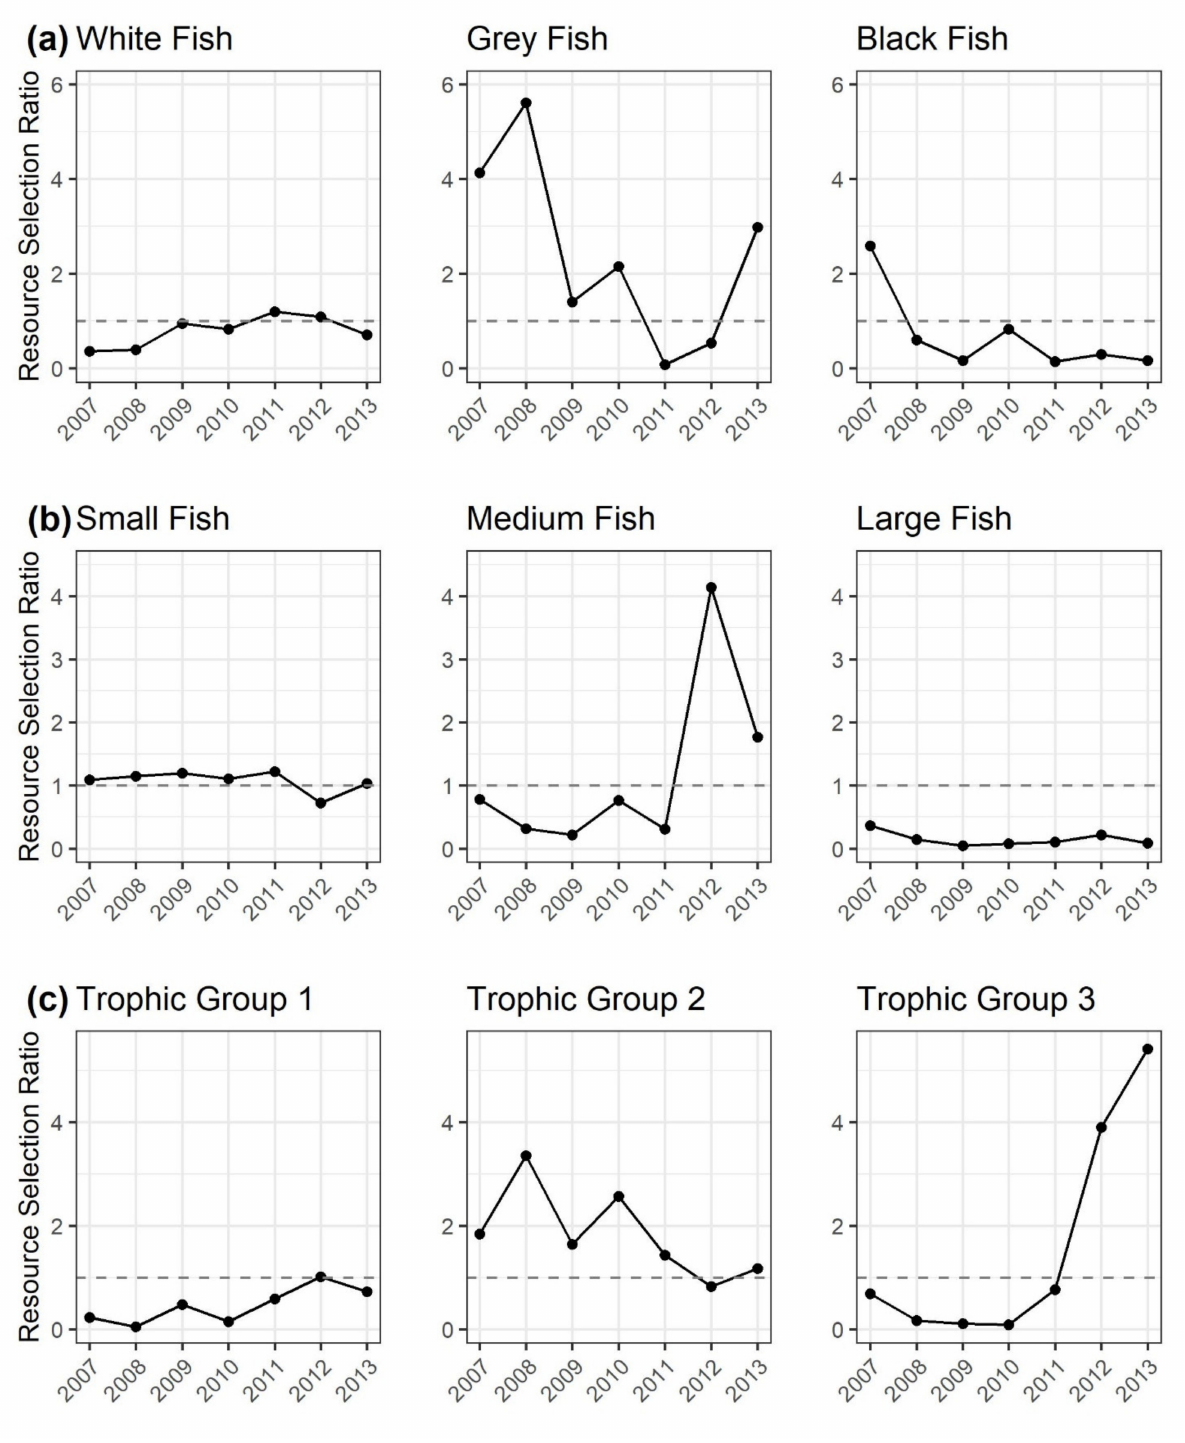
Figure 5. Resource selection ratios for the trait groups estimate selection by the gillnet fishery relative to the Dai fishery. Grey dashed line represents when the resource selection ratio equals 1, when the group is represented equally by both fisheries. ( a ) Selection for migratory guilds. “White” fish are longitudinal migrants, “grey” fish are latitudinal migrants, and “black” fish are floodplain residents. ( b ) Selection for body size groups. Small fish are <25 cm total length, medium fish are 25–60 cm, and large fish are >60 cm. ( c ) Selection for trophic level groups. Trophic group 1 are fish of trophic level <2.75, trophic group 2 are 2.75–3.75, and trophic group 3 are >3.75. Note the difference in scale on the y-axis for all trait